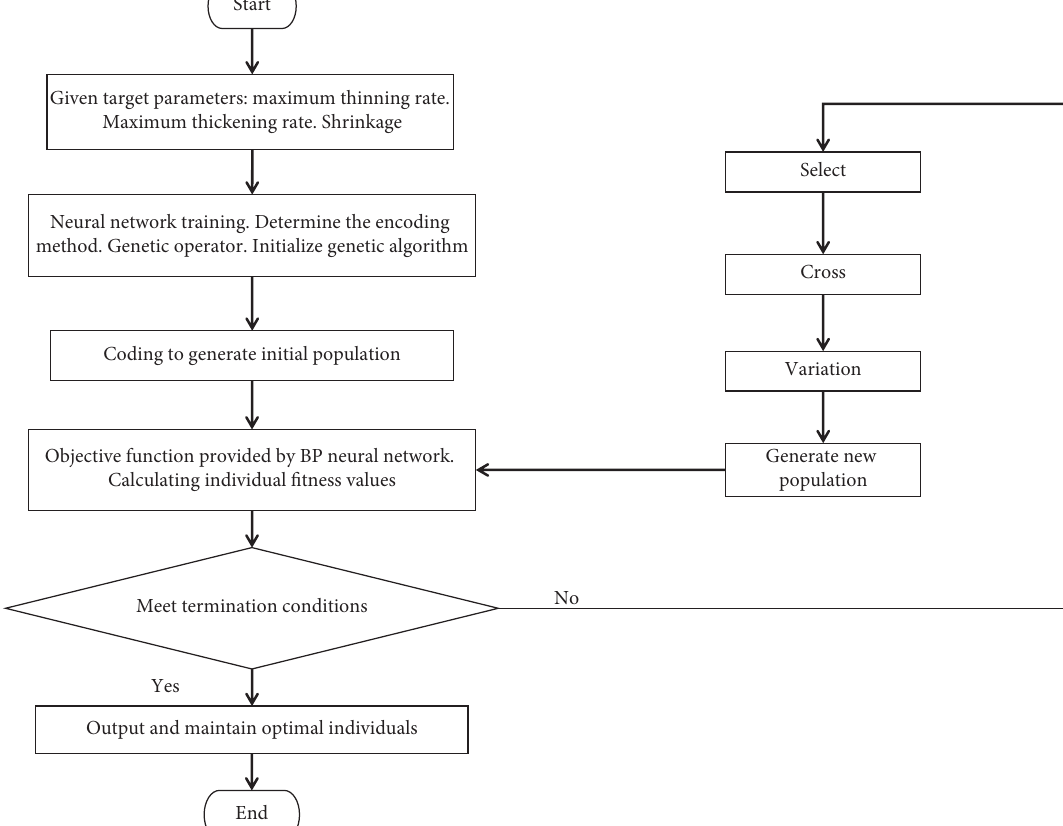
Figure 26: Flow chart of genetic algorithm to optimize molding parameters.